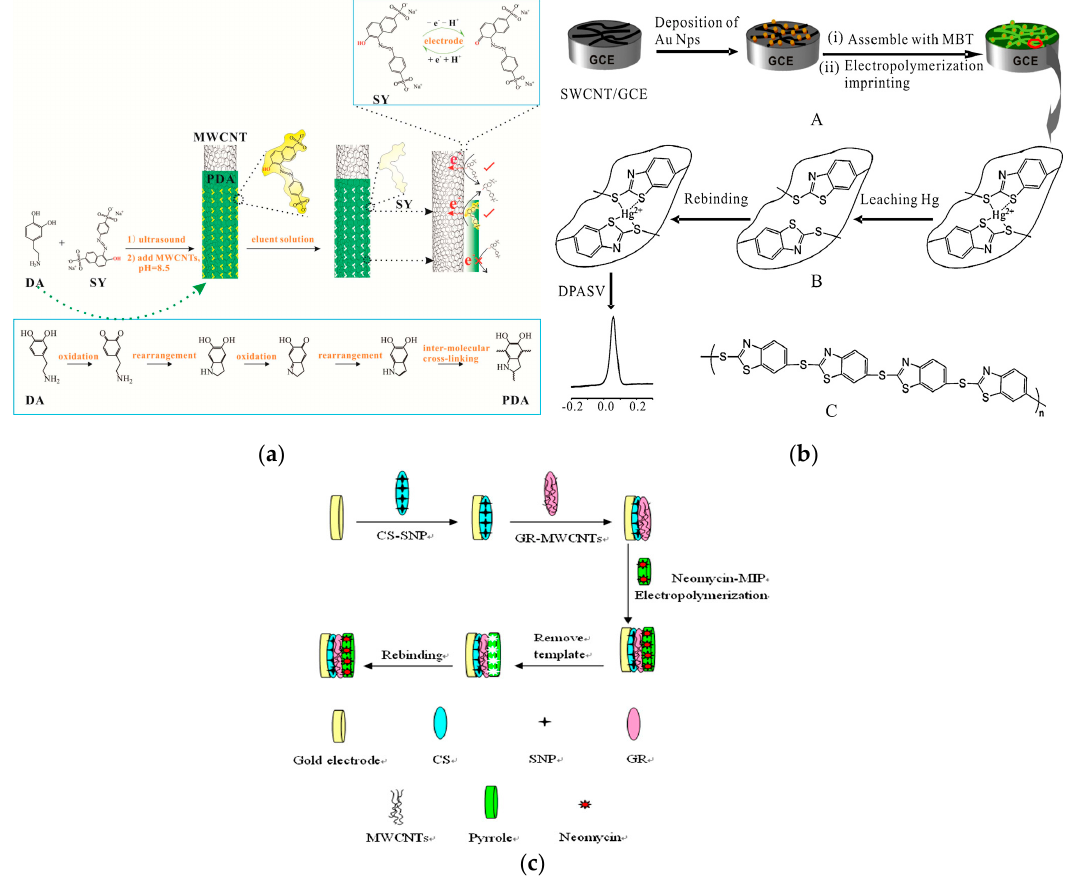
Figure 4. Application of CNTs in MIP-based sensors. ( a ) Fabrication of MWCNT@MIP-PDA sensor for sunset yellow. Reproduced with permission from reference [97]. Copyright 2018 Elsevier. ( b ) Schematic diagram of Hg(II)-imprinted PMBT/AuNPs/SWCNTs/GCE. Reproduced with permission from reference [102]. Copyright Elsevier, 2012. ( c ) Preparation of CS-SNP/graphene-MWCNTs composite-decorated gold electrode. Reproduced with permission from reference [103]. Copyright Elsevier, 2013.